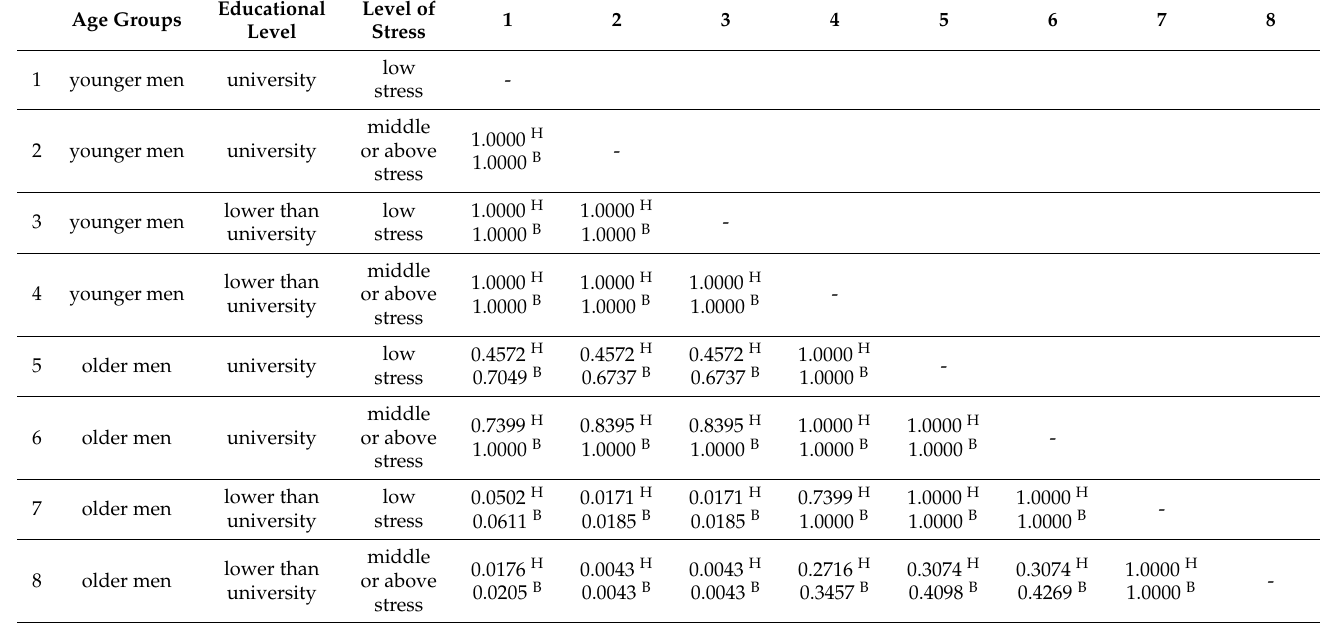
Table 4. Multiple comparisons of mean ranks for all groups in severity of all aging males’ symptoms ( p -values with Holm and Bonferroni corrections for multiple, two-sided